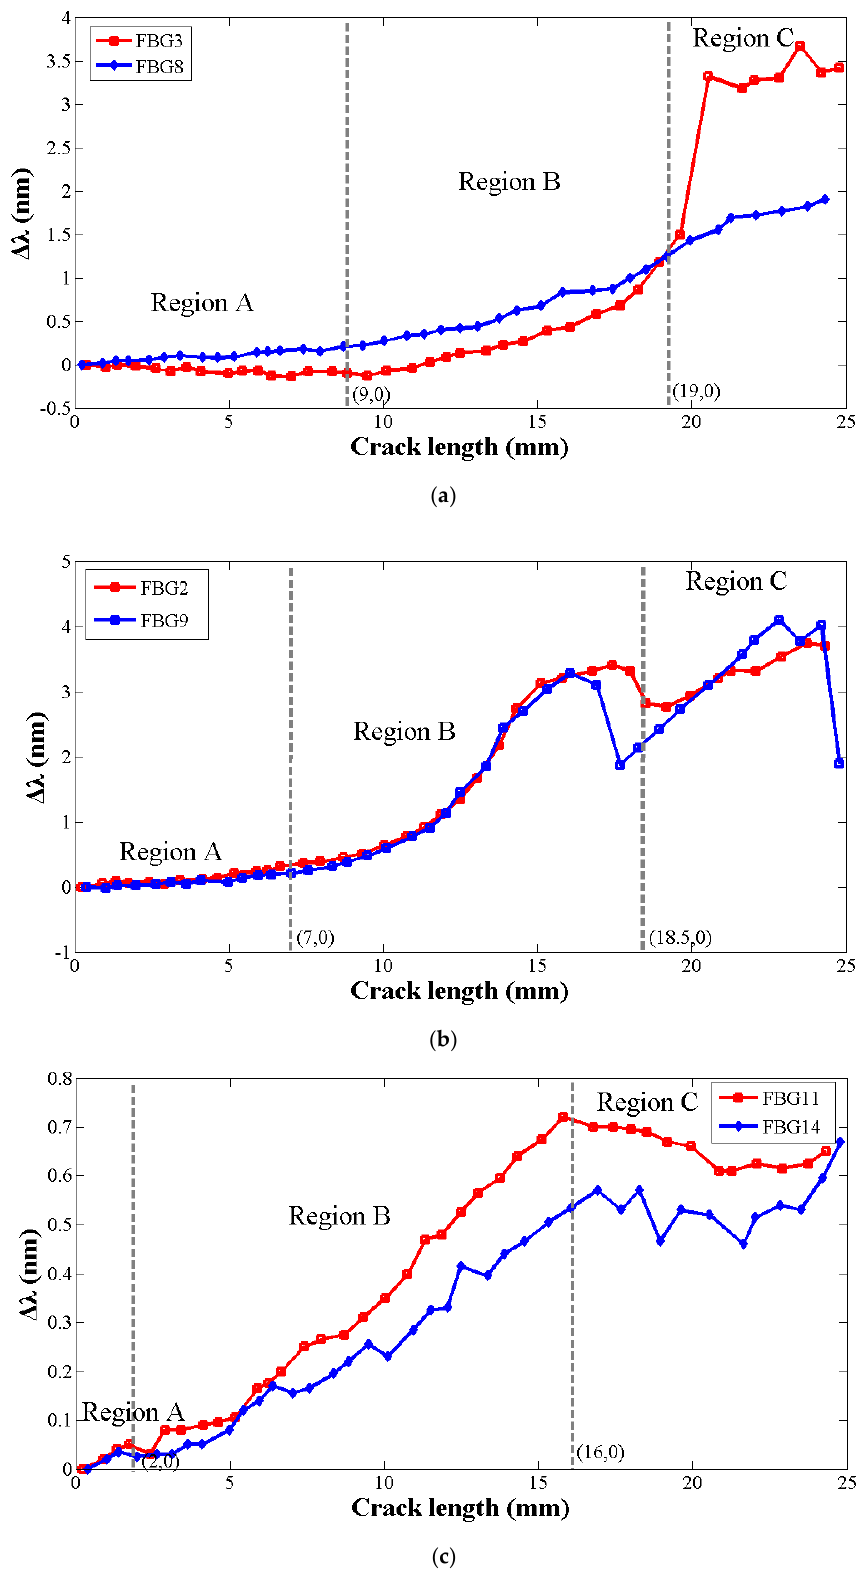
Figure 18. The central wavelength shifting of different FBG in various crack lengths. ( a ) The central wavelength shifting of FBG3 and FBG8, ( b ) The central wavelength shifting of FBG2 and FBG9, ( c ) The central wavelength shifting of FBG11 and FBG14.